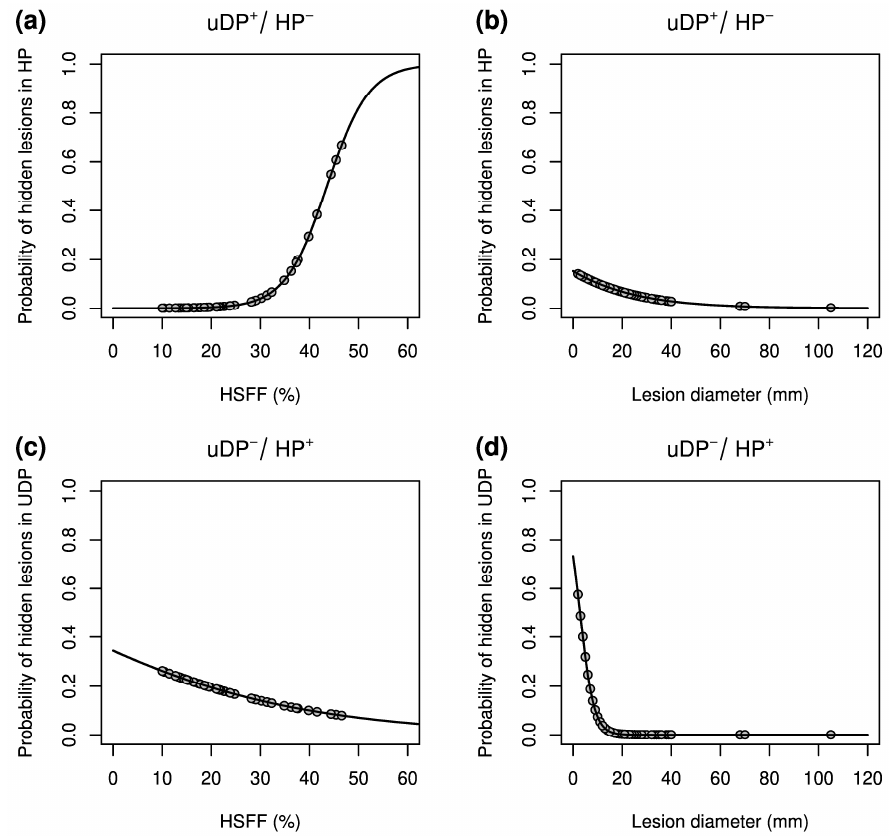
Figure 4. The probability of lesions visible exclusively in the unenhanced and dynamic phase im- ages (uDP + /HP − ) notably increases with the hepatic signal fat fraction (HSFF), beginning at about 30% ( a ). This phenomenon tends to occur predominantly in small lesions ( b ). In contrast, the prob- ability for lesions visible exclusively in the hepatobiliary phase images (uDP − /HP + ) increases as the HSFF decreases ( c ) and peaks for lesions with diameters smaller than approximately 20 mm ( d ).